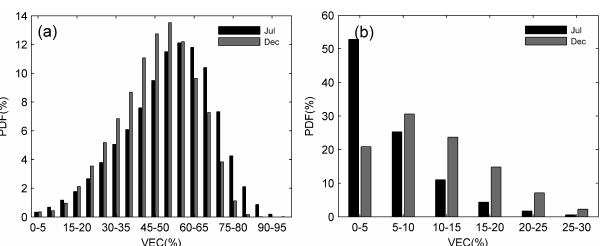
Figure 5. The probability density function (PDF) of instantaneous VECs for NO 2 (a) and PM 2 . 5 (b)